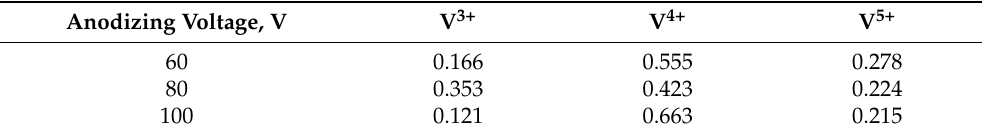
with Ea (Table 2). Table 2. The relative proportions of vanadium species according to V 2 p 3/2 spectrograms of the films fabricated as in Table